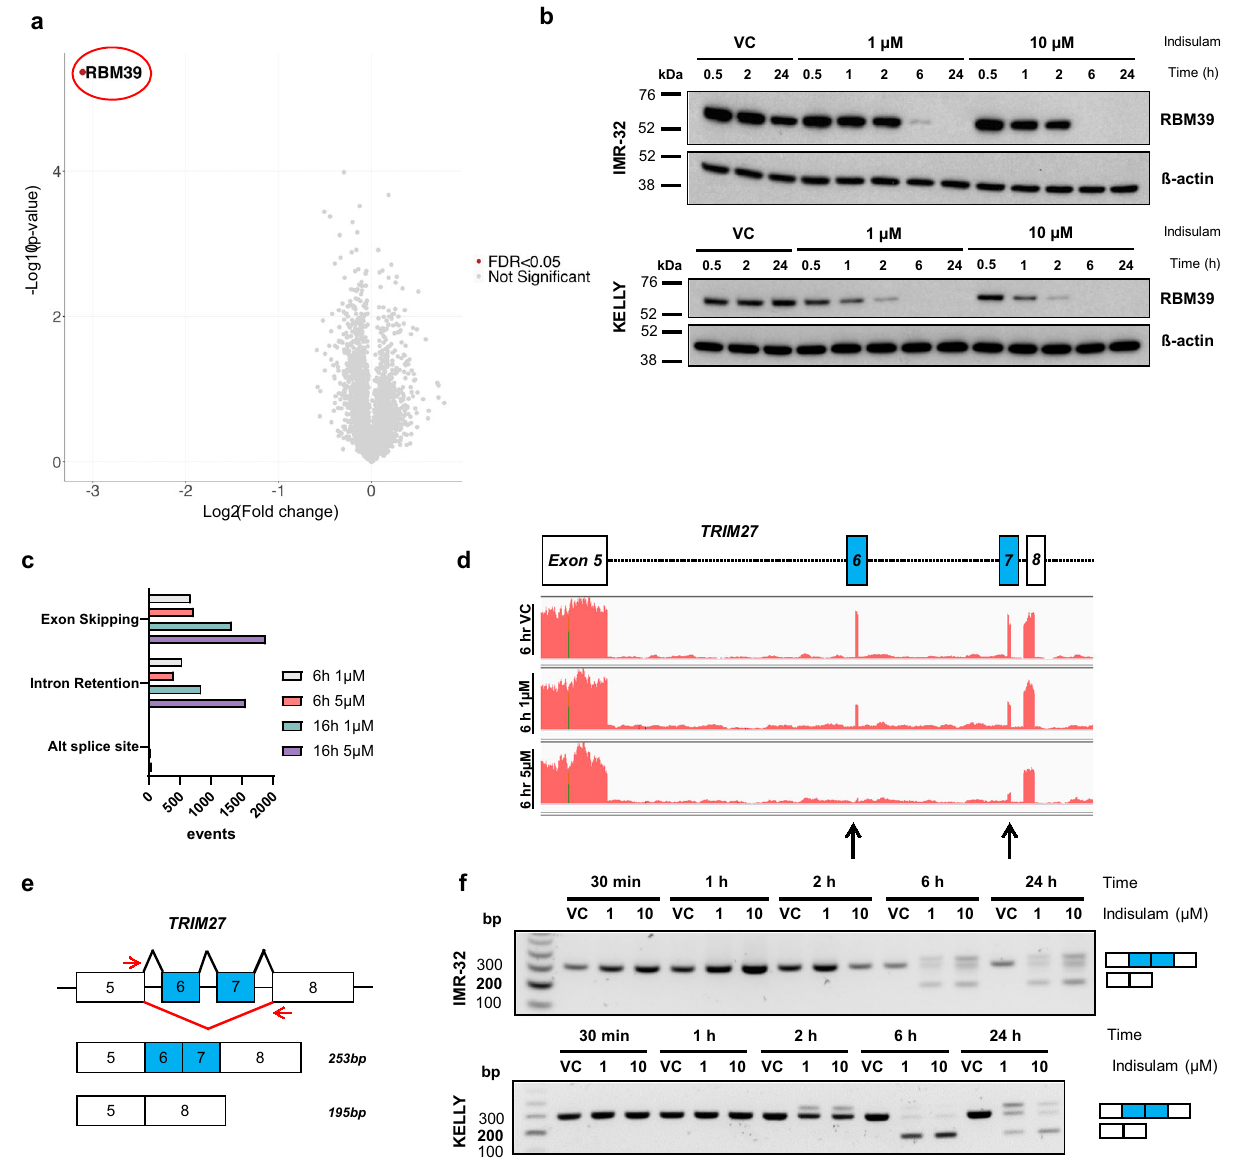
Fig. 2 Indisulam causes selective degradation of RBM39 and subsequent mis-splicing of RNA. a Volcano plot of proteomic analysis in IMR-32 cells treated with 5 µ M indisulam or VC (0.1% DMSO) for 6 h. RBM39 is highlighted in red. b Western blot of IMR-32 and KELLY cells treated with vehicle control (VC), 1 or 10 µ M indisulam for 0.5 – 24 h. Representative blot for n = 2 independent experiments. c Number of RNA splicing events (SpliceFisher analysis, n = 3 independent experiments) in IMR-32 cells following treatment with VC or 5 µ M indisulam for 6 or 16 h. d RNA read counts of TRIM27 (exon 5 – 8) in IMR-32 cells treated with VC (top), 1 µ M (middle), or 5 µ M (bottom) indisulam for 6 h. Black arrows indicate loss of exons 6 and 7. Plot generated with IGV. e Diagram of custom primers to detect skipping of exon 6 and 7 of TRIM27 . f PCR of TRIM27 (exon 5 – 8) in IMR-32 (top) and KELLY (bottom) cells treated with VC, 1 or 10 µ M indisulam for 0.5 – 24 h. Representative blot for n = 2 independent experiments. Source data is provided as a Source Data